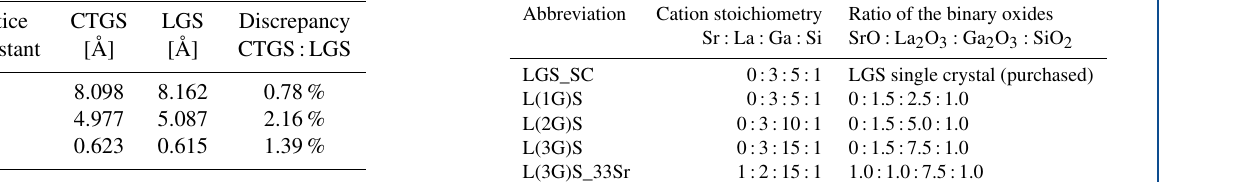
Table 1. Lattice constants of CTGS and LGS single crystals (Bohm et al., 1999; Wang et al., 2003; Kugaenko et al., 2012). Lattice CTGS LGS Discrepancy